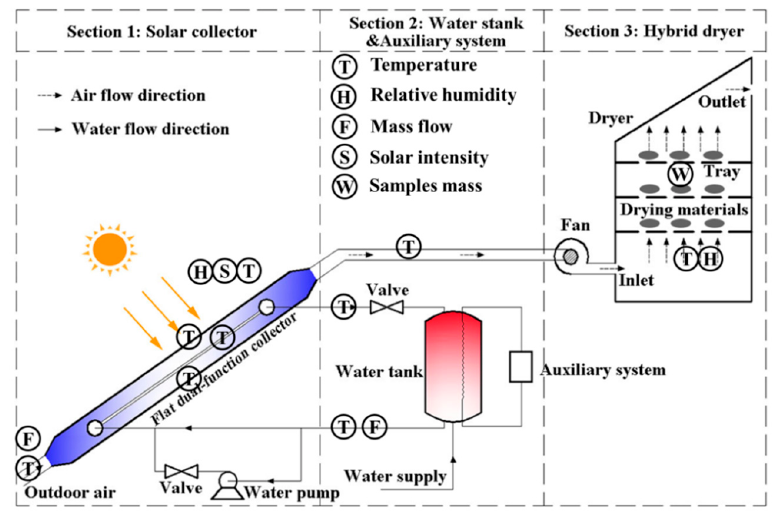
Figure 4. The schematic diagram of the experimental test system. Table 2. Characteristics of the test instrument.